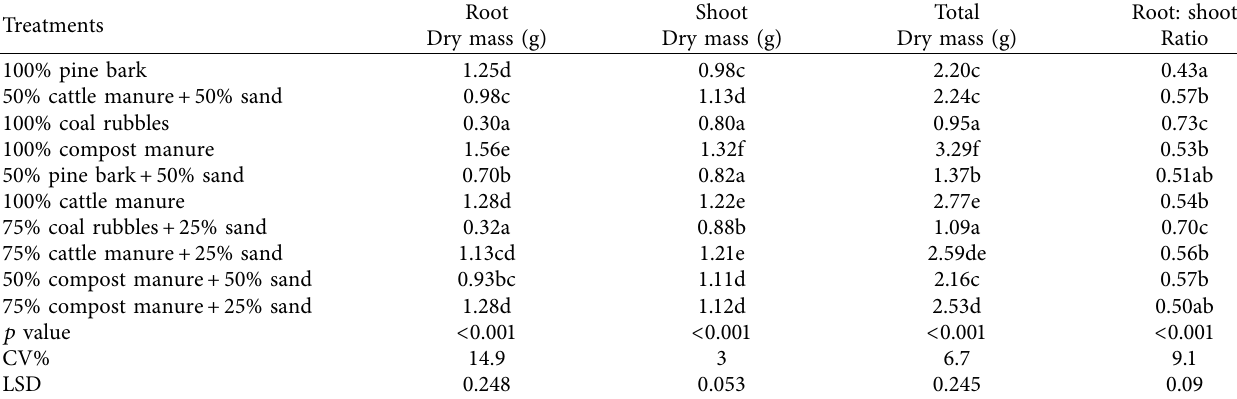
Table 4: The effect of soilless growing media on roots, shoots, and overall dry matter of tobacco seedlings. Treatments